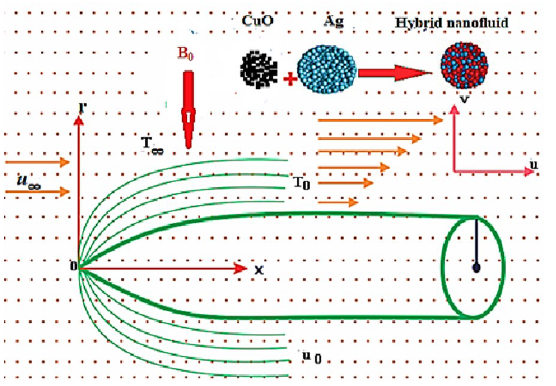
Fig 1. Schematic diagram of the